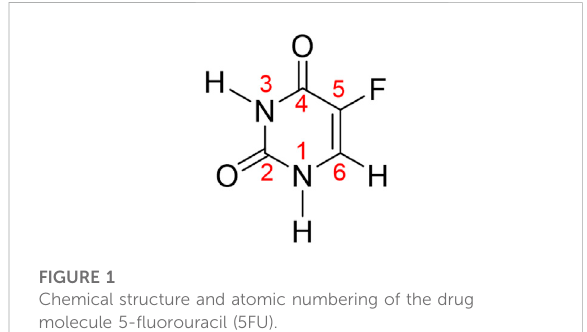
FIGURE 1 Chemical structure and atomic numbering of the drug molecule 5- fl uorouracil